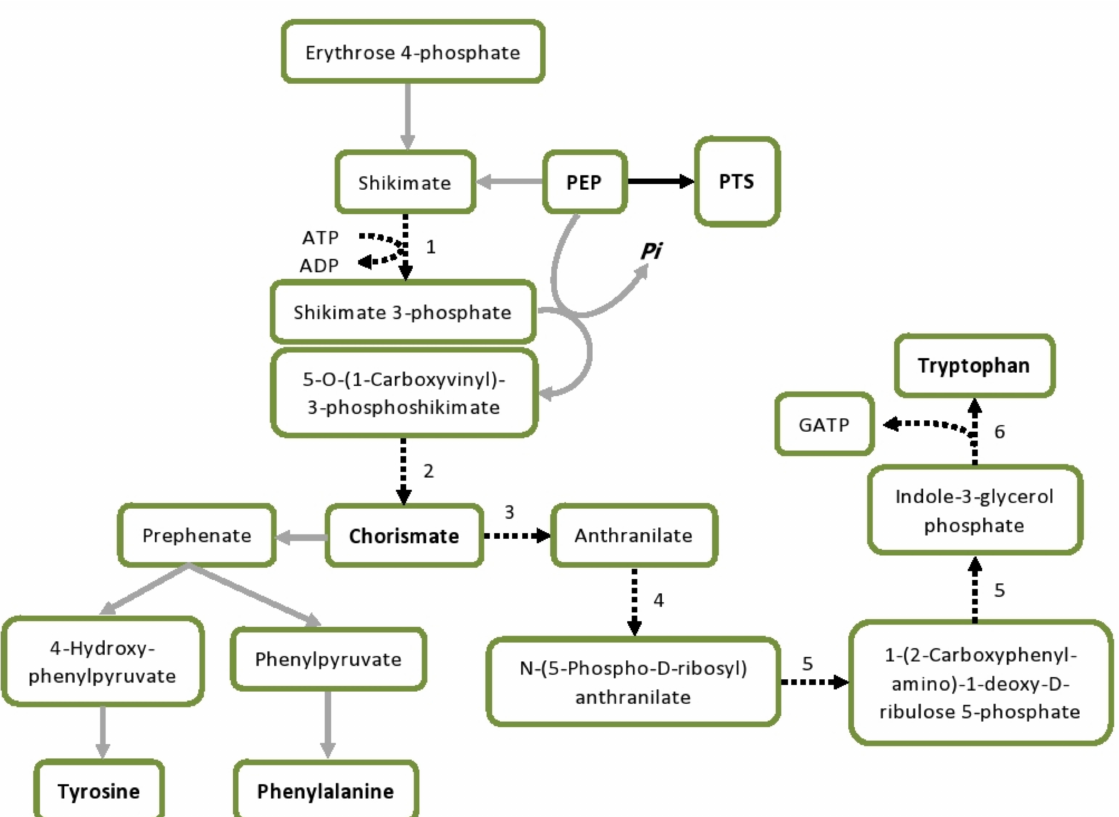
Figure 9. Inhibition of tryptophan biosynthesis and redistribution of PEP under butanol stress in L. plantarum Ym1. Downregulated steps are marked with dotted lines. Enzymes: 1, shikimate kinase; 2, chorismate synthase; 3, anthranilate synthase; 4, anthranilate phosphoribosyltransferase; 5, phosphoribosyl anthranilate isomerase; 6, tryptophan synthase. Abbreviations: GATP, glyceraldehyde 3-phosphate; GNG, gluconeogenesis; PEP, phosphoenolpyruvate; Pi, inorganic phosphate; PTS, PEP: carbohydrate phosphotransferase